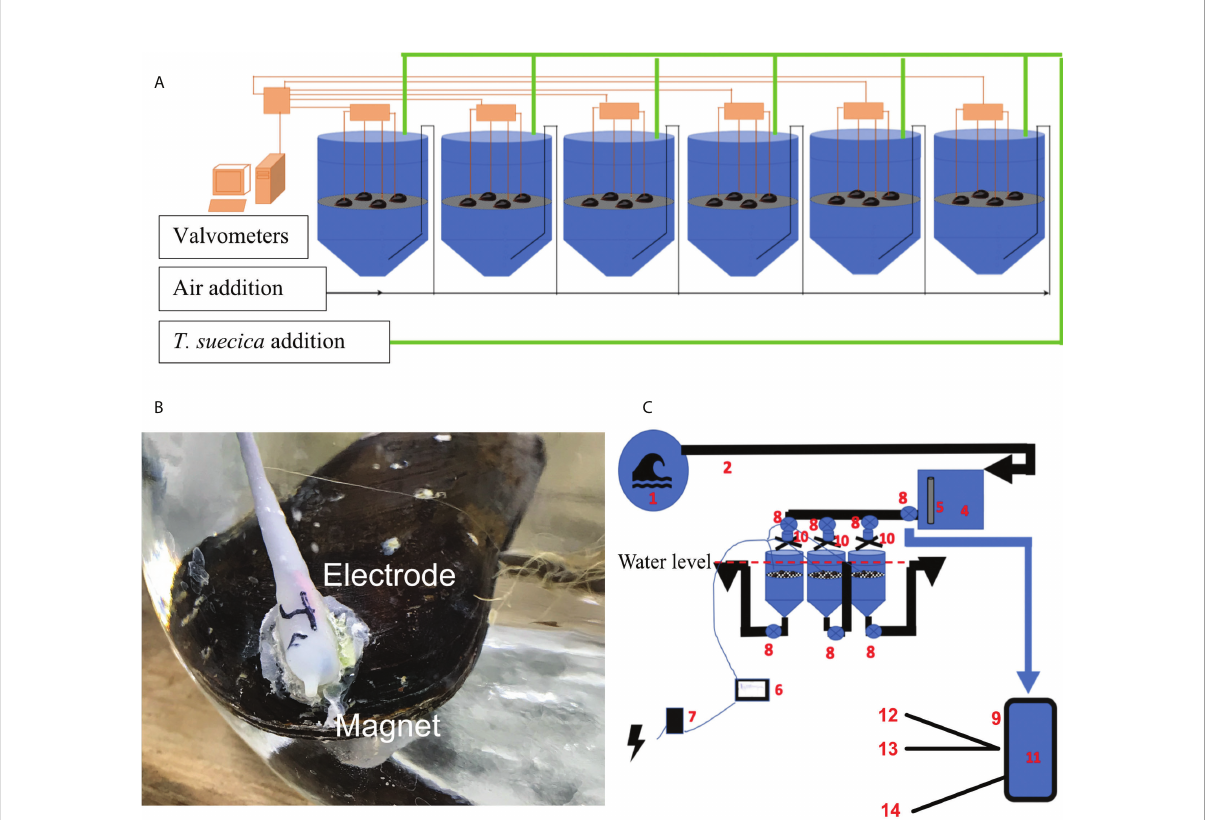
FIGURE 1 Experimental design of the lab experiment, 4 mussel per tanks, T. suecica added after 48h (A) , picture of mussel with electrode (B) and of the natural seawater experiment (C) , 1: seawater, 2: water intake, 3: water pump, 4: head tank, 5: CTD, 6: valvometers, 7: battery, 8: Tap, 9: sample, 10: fl owmeter, 11: water sampled, 12: Elisa test, 13: cell count, 14: Jellet